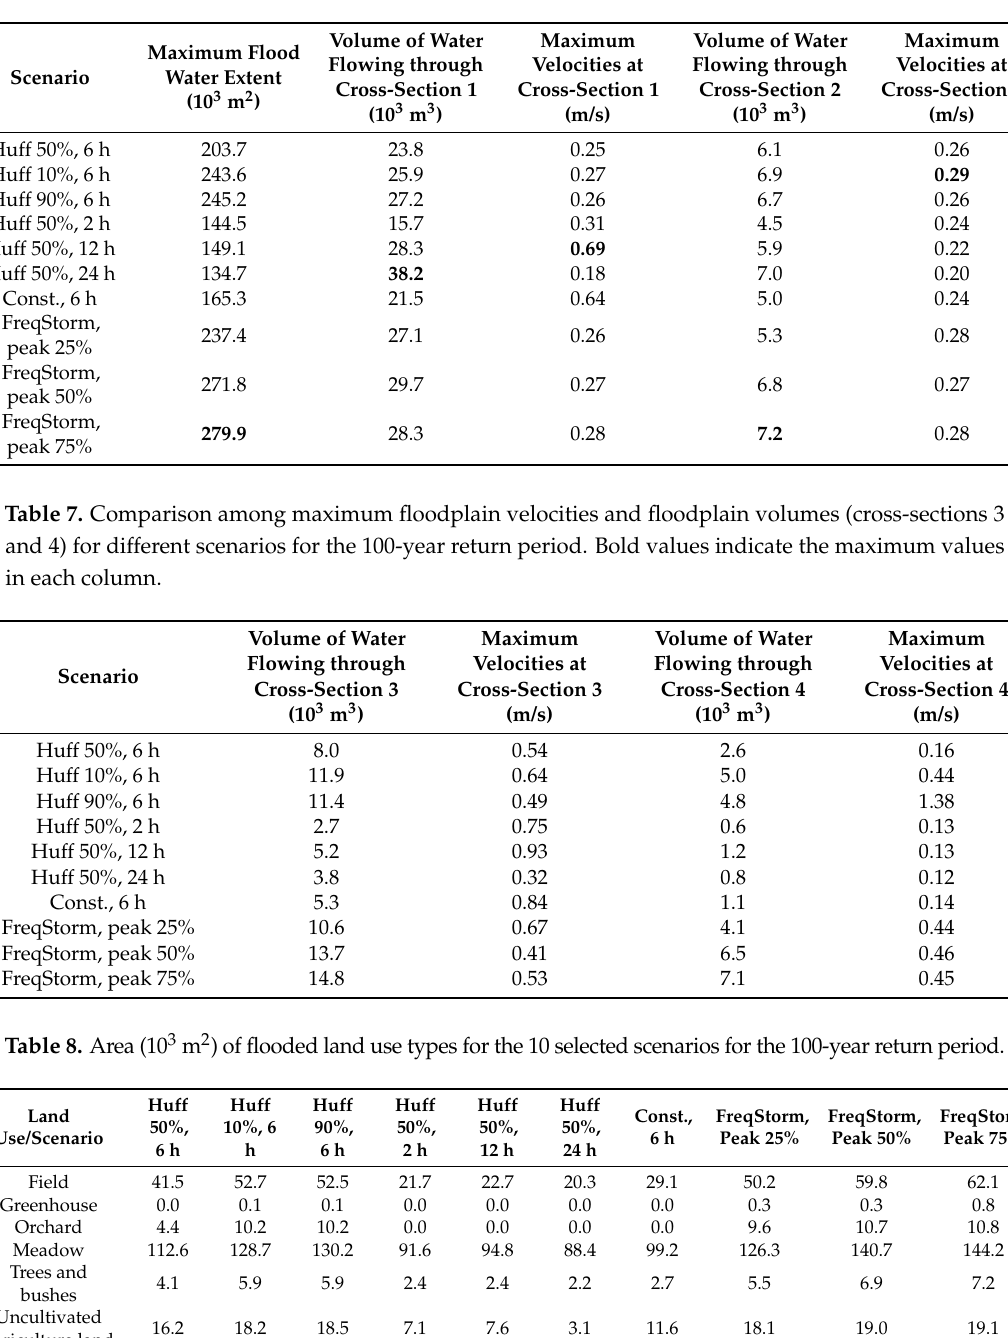
Table 6. Comparison among maximum floodplain extents, maximum floodplain velocities, and floodplain volumes (cross-sections 1 and 2) for the 10 selected scenarios for the 100-year return period. Bold values indicate the maximum values in each column.